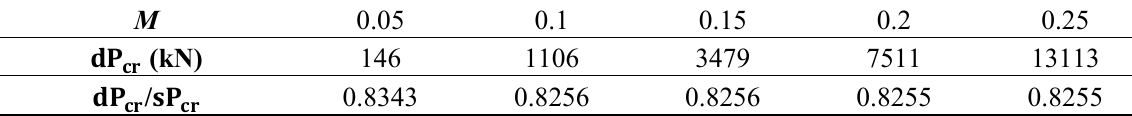
) ( h = (cid:2913)(cid:2928)